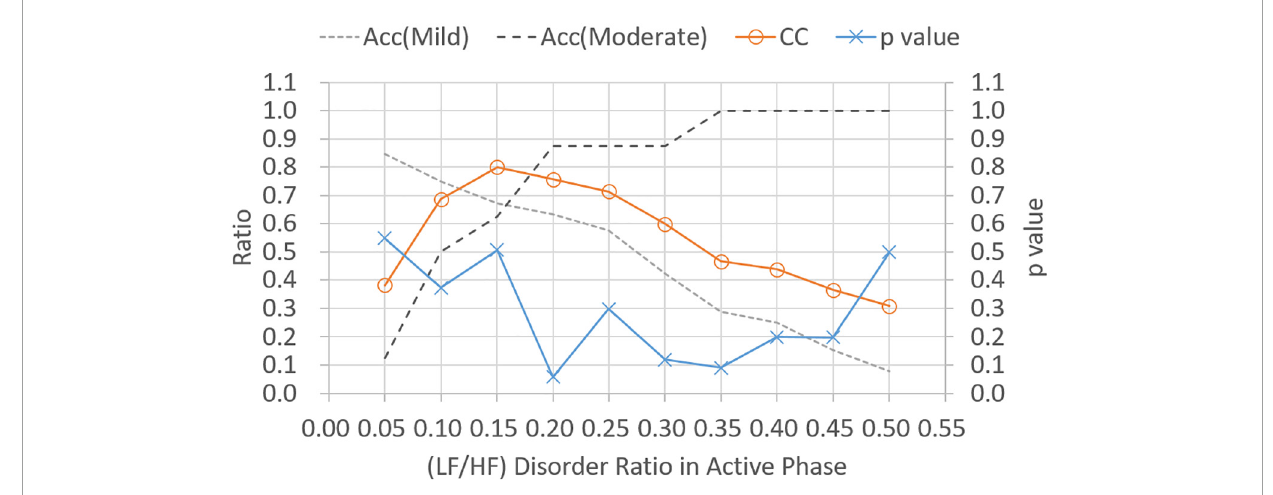
FIGURE7 Classification ratio and p -value obtained from t -test between mild and moderate categories for varied (LF/HF) disorder ratio in the active phase. “Acc” stands for classification accuracy.